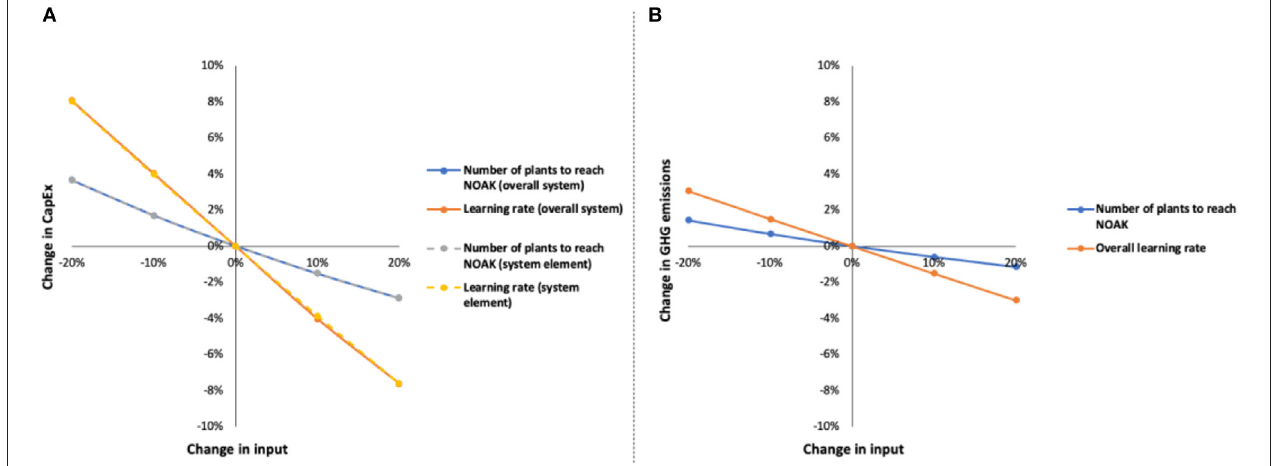
FIGURE 4 | One-way, local sensitivity analysis calculating (A) CapEx and (B) GHG emissions altering the assumed number of plants and learning rates around their base values. Base value for the number of plants is 10, and the base values for the learning rates for CapEx are 10.55% (overall system), 10.53% (system element), and 4.35% for GHG